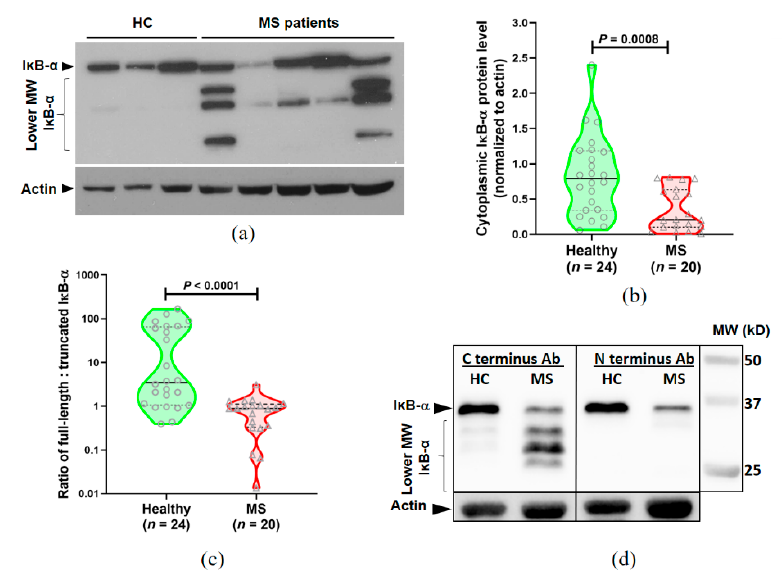
Figure 2. Reduced I κ B- α levels in MS. ( a ) Western blot of the cytosolic fraction of PBMC showing Table 36. kD and multiple lower MW bands, particularly in MS patients. ( b ) Violin plots showing the results of the level of full-length (36 kD) I κ B- α in the cytosolic fraction of PBMC from healthy individuals or MS patients, normalized to actin. In these violin plots, a solid horizontal line indicates the median, and dotted horizontal lines show the interquartile range. ( c ) Violin plots of the ratio of the full length I κ B- α vs the lower MW form in PBMC from healthy individuals or MS patients show a highly significant di ff erence between healthy subjects and patients with MS. ( d ) Representative Western blot showing that the truncated / degraded I κ B- α bands could be detected using antibodies specific for the C-terminus but not the N-terminus of I κ B- α . For statistical analyses, comparisons between healthy individuals and the MS group were analyzed by two-tailed Mann–Whitney U test.